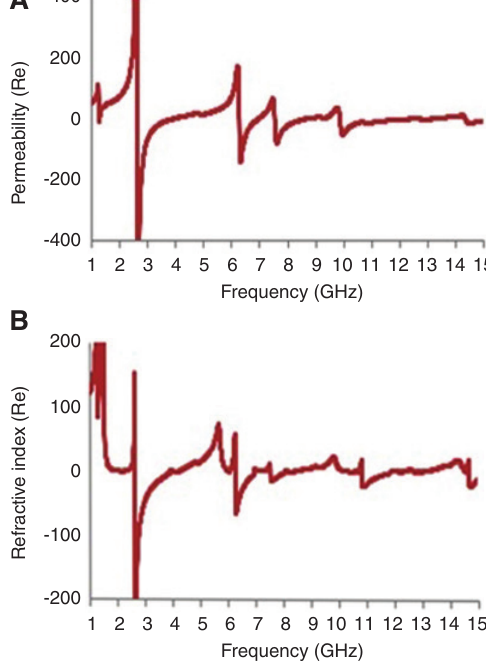
Figure 2: (A) Simulated reflection coefficient (S magnitude of permittivity.